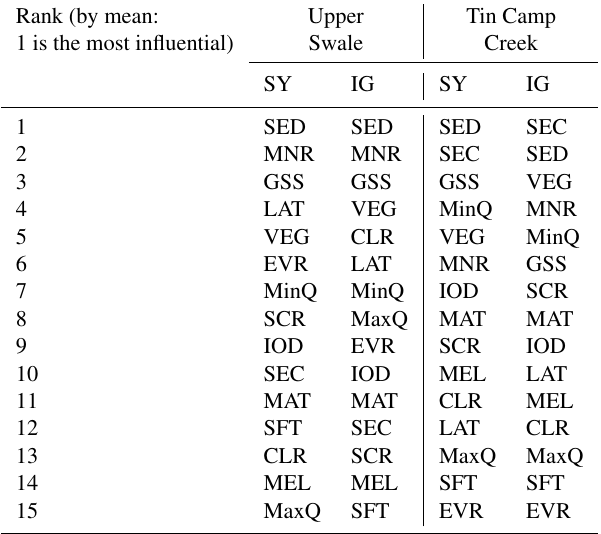
Table 4. Parameters ranked by means for each catchment from the aggregated scores for catchment sediment yields (SY) and inter- nal geomorphology (IG) elementary effects. SED is the sediment transport formula; MEL is the maximum erode limit; CLR is the in channel lateral erosion rate; LAT is the lateral erosion rate; VEG is the vegetation critical shear stress; MAT is the grass maturity rate; SCR is the soil creep rate; SFT is the slope failure threshold; IOD is the in/out difference; MinQ is the minimum Q value; MaxQ is the maximum Q value; SEC is the slope for edge cells; EVR is the evaporation rate; MNR is the Manning n roughness coefficient; and GSS is the grain size